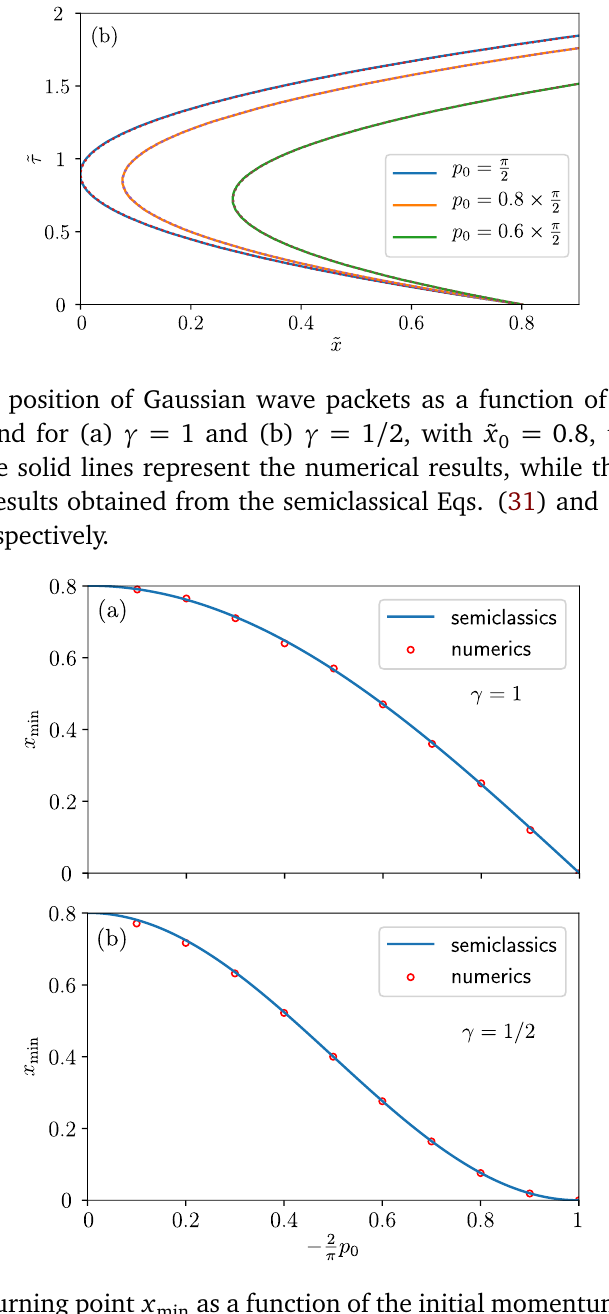
as a function of the initial momentum p min